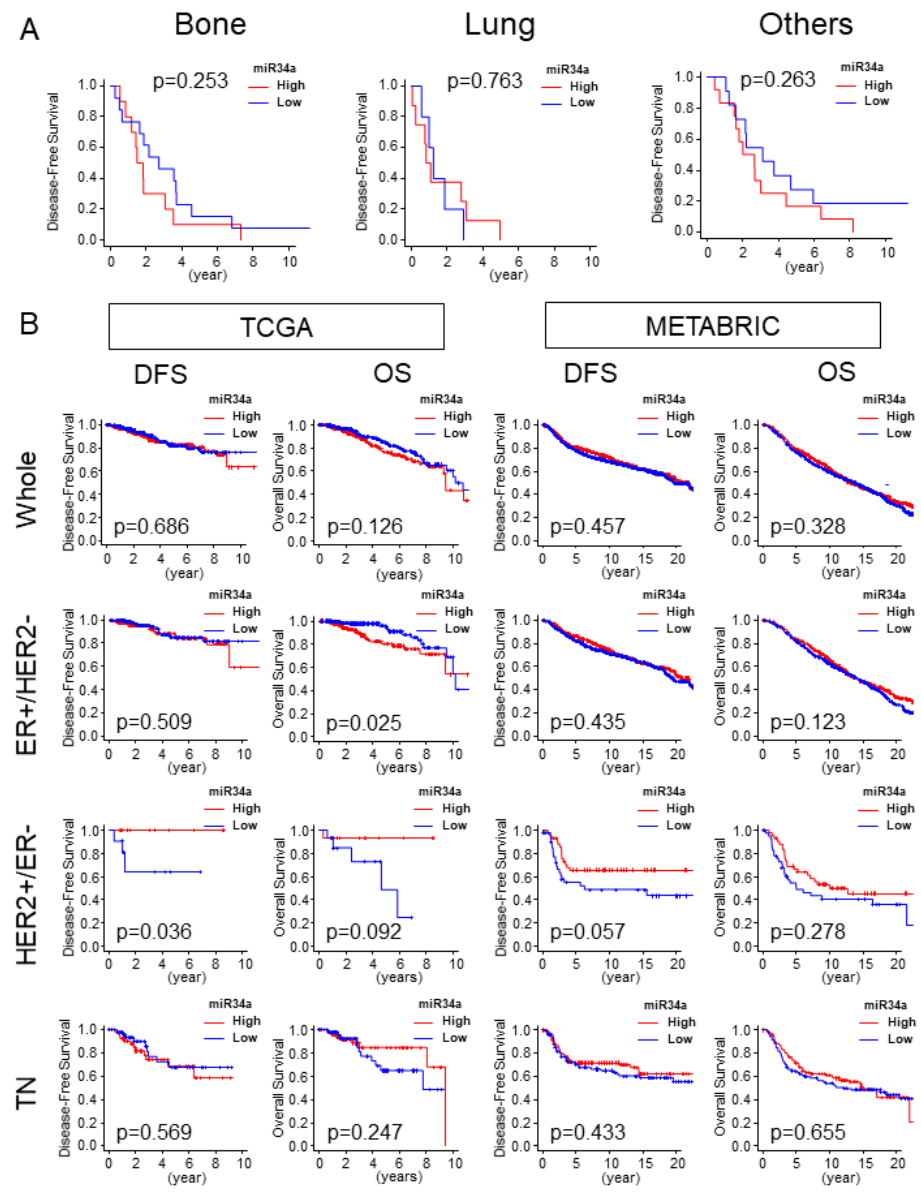
Figure 6. High miR-34a expression tumor was not associated with distant metastasis and was not associated with better survival outcomes. ( A ) Disease-free survival (DFS) of bone, lung, and other metastases in the TCGA cohort. Bone, n = 23, high = 10, low = 13; lung, n = 13, high = 8, low = 5; n = 23, high = 12, low = 11. ( B ) DFS and OS by miR-34a expression in the whole cohort, and each subtype in TCGA and METABRIC. TCGA cohort (whole, n = 752, high = 376, low = 376; ER +/ HER2 − , n = 407, high = 204, low = 203; HER2 +/ ER − , n = 30, high = 15 Low = 15; TN, n = 117, high = 59, low = 58). METABRIC cohort (Whole, n = 1282, High = 641 Low = 641; ER +/ HER2 − , n = 907, High = 455 Low = 452; HER2 +/ ER − , n = 86, High = 43 Low = 43; TN, n = 207, High = 104 Low = 103). DFS, Disease-Free Survival; OS, Overall